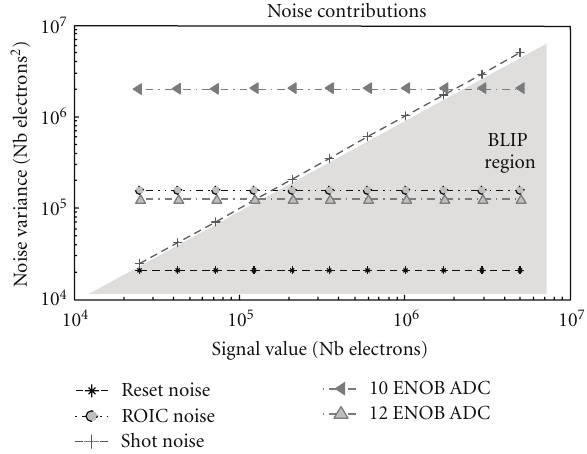
Figure 1: Noise contributions in an infrared